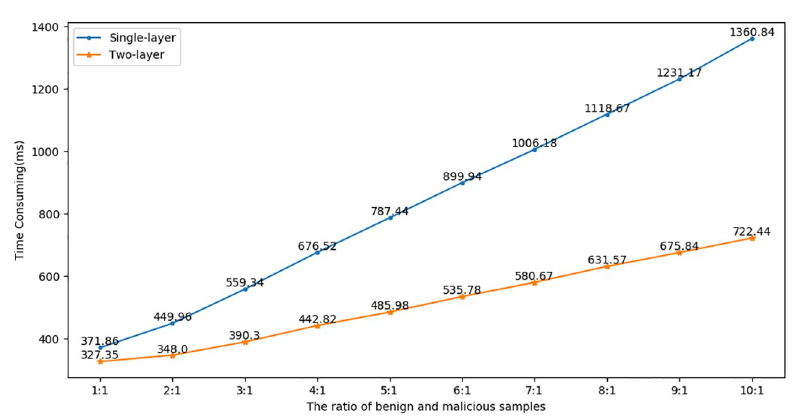
Fig 9. Time consumption at different ratios.